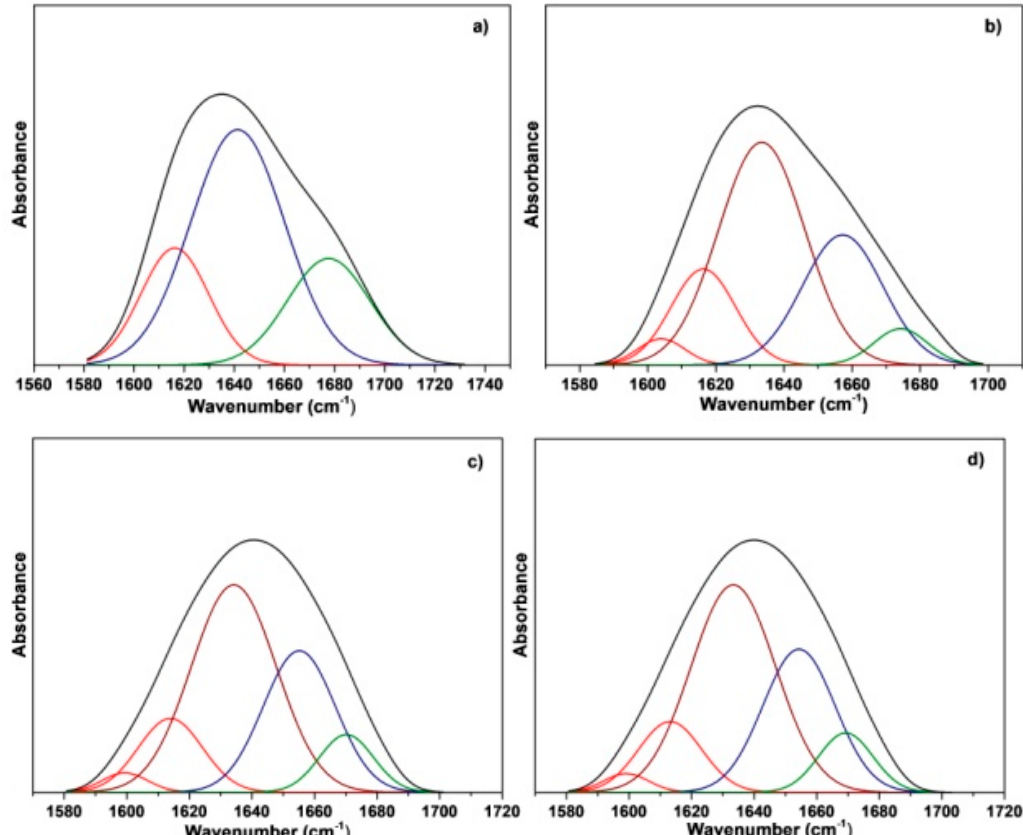
Figure 5. Curve fitting spectra of amide I band (black curve) for ( a ) FG powder, ( b ) FG, ( c ) FG + NaOH, and ( d ) thermal treated FG+NaOH electrospun mats ( β -sheet conformation, red curve; random coil conformation, brown curve; α -helix conformation, blue curve; β -turn conformation, green curve). Table 1. Resulting percentage of the curve fitting of amide I for FG powder, FG, FG + NaOH, and thermal treated FG + NaOH electrospun